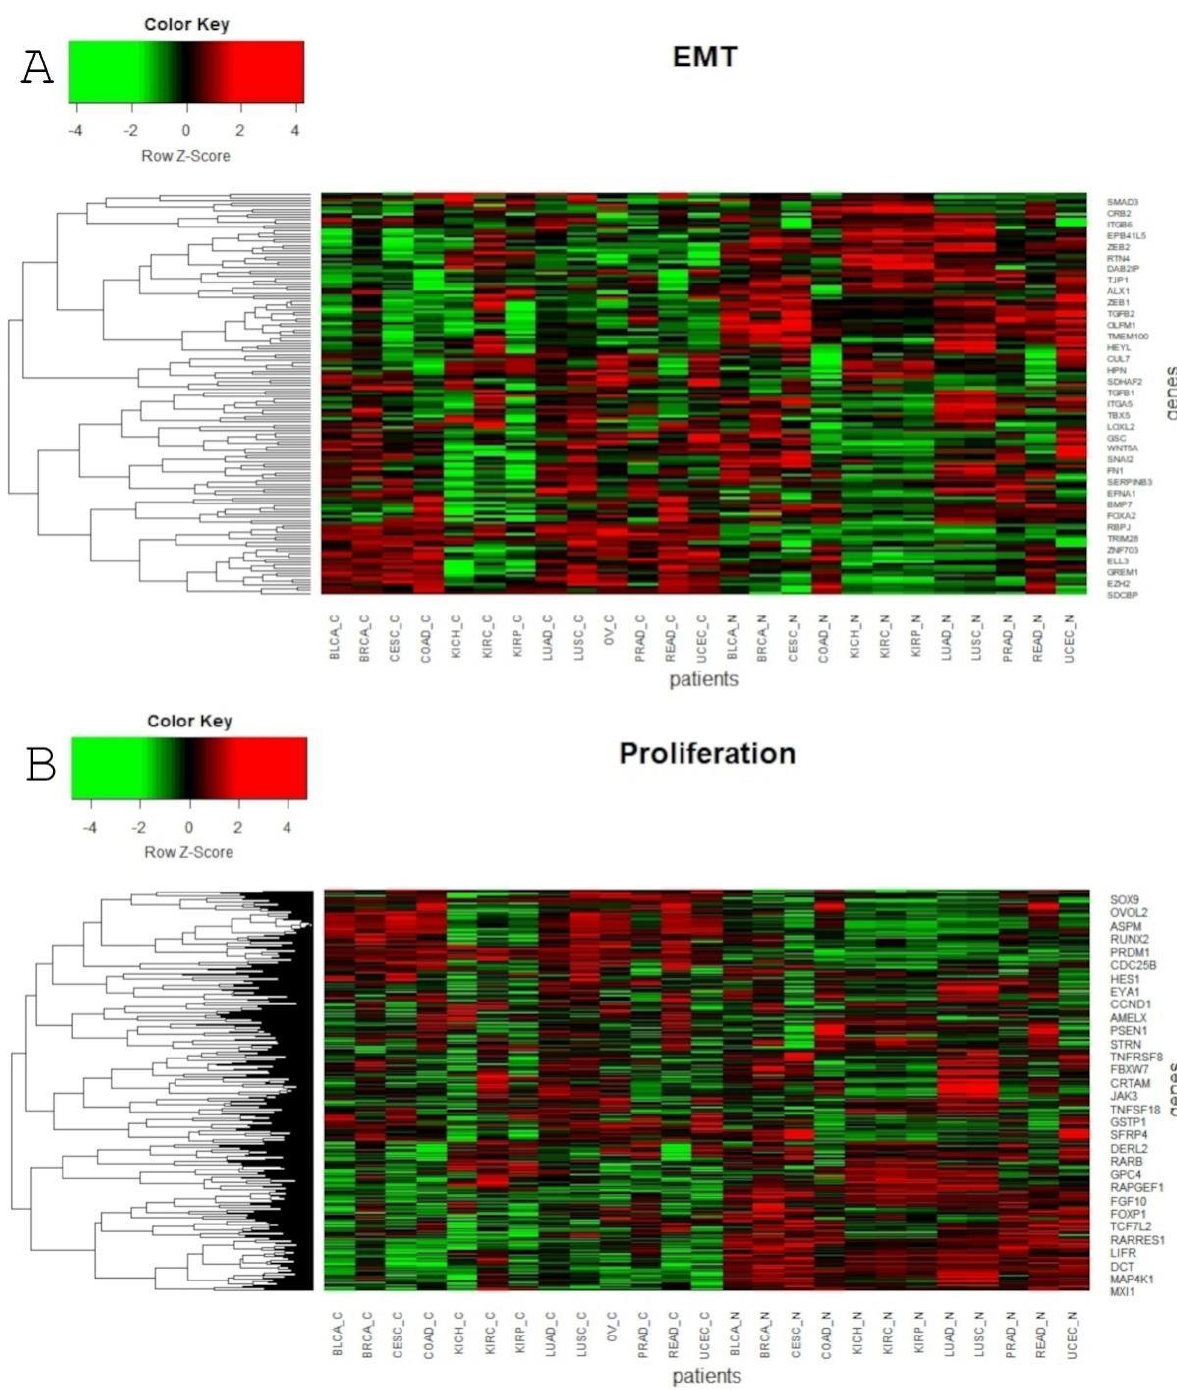
Figure 6. Heatmap reflecting differential median gene expression of Notch target genes in the analyzed cancerous and normal tissues. Target genes are grouped into four biological processes: ( A ) EMT; ( B ) Proliferation.